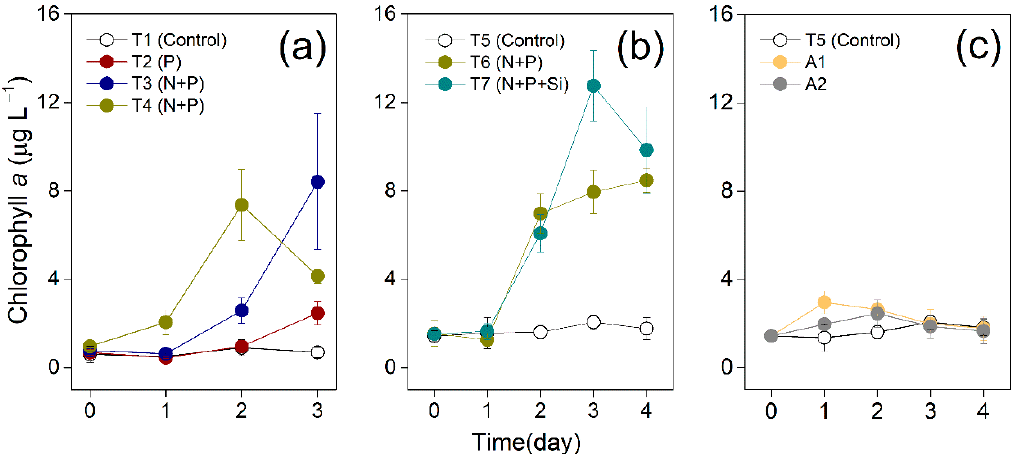
Figure 3. Change of Chl a concentrations in 2012 ( a ) and 2014 ( b ) and ( c ) bioassay experiments including controls (T1 and T5) and treatments adding 0.6 μ mol L − 1 PO 43 − (T2), 0.6 μ mol L − 1 PO 43 − +1 μ mol L − 1 NH 4+ +9 μ mol L − 1 NO 3 − (T3), 0.6 μ mol L − 1 PO 43 − + 6 μ mol L − 1 NH 4+ + 4 μ mol L − 1 NO 3 − (T4), 0.6 μ mol L − 1 PO 43 − + 6 μ mol L − 1 NH 4+ +4 μ mol L − 1 NO 3 − (T6), 0.6 μ mol L − 1 PO 43 − +6 μ mol L − 1 NH 4+ + 4 μ mol L − 1 NO 3 − + 10 μ mol L − 1 SiO 32 − (T7), aerosol 1 (A1 sampled on 31 March 2012), and aerosol 2 (A2 sampled on 27 October 2012).